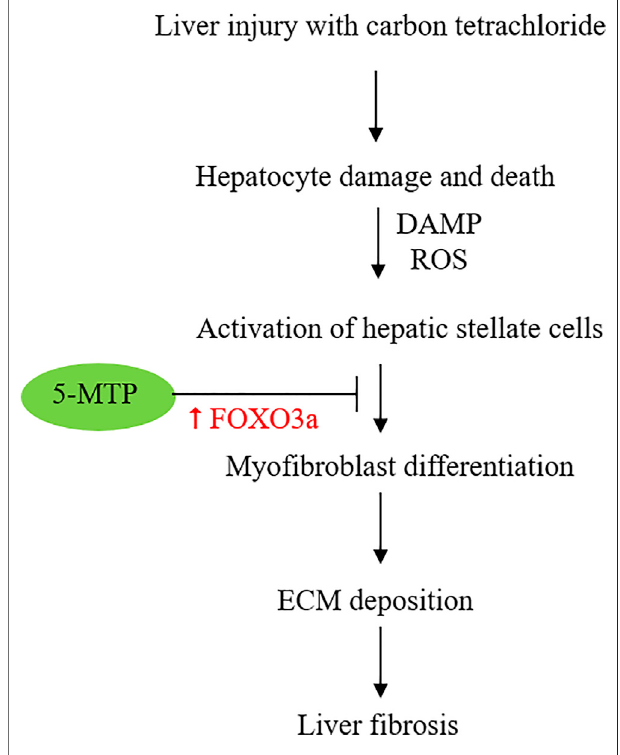
FIGURE 3 | Schematic illustration of the effect of 5-MTP on attenuating HSC differentiation to myo fi broblasts via FOXO3a upregulation. FOXO3a was reportedtosuppressmiR21expressionandtherebyrestoreATG5andATG5- mediated